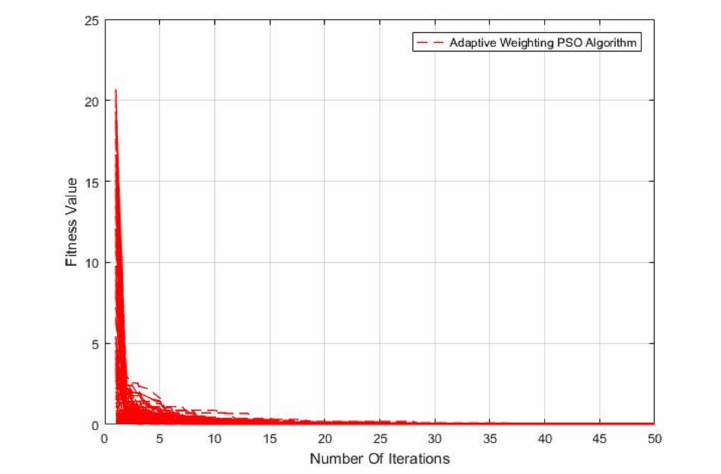
Figure 9. Convergence curve of PSO